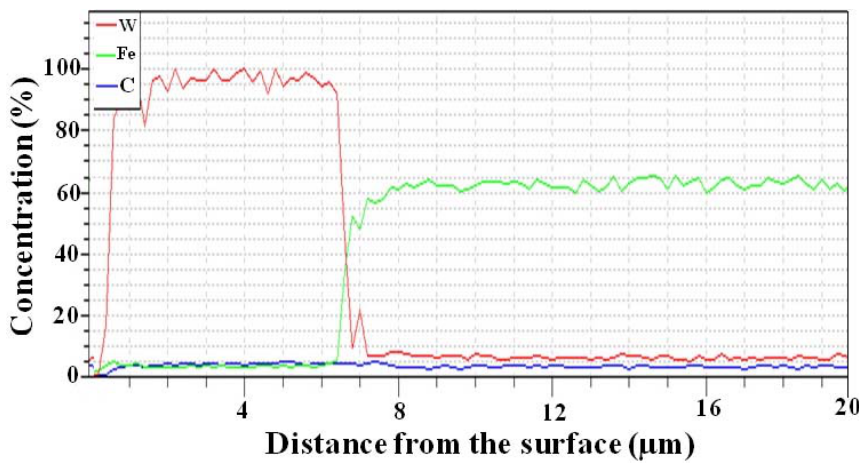
Figure 11. Analysis of the cross section of sample AFD250550 up to 20 μ m from the surface.